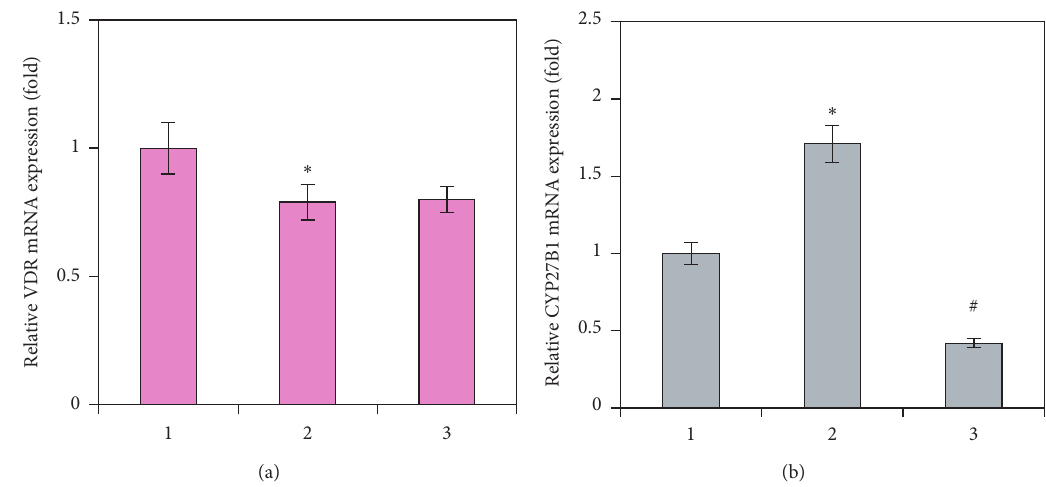
Figure 2: Effects of prednisolone and vitamin D 3 administration on Vdr and Cyp27b1 mRNA expression in bone tissue. Vdr (a) and Cyp27b1 (b) mRNA levels were determined by quantitative RT-PCR in bone tissue of three animal groups: (1) control; (2) prednisolone administration; (3) prednisolone and vitamin D 3 administration. mRNA levels were normalized to Gapdh expression. All data are presented as mean ± SEM of three independent experiments done in triplicate; ∗ p < 0 . 05 vs. control; # p < 0 . 05 vs. prednisolone administration.